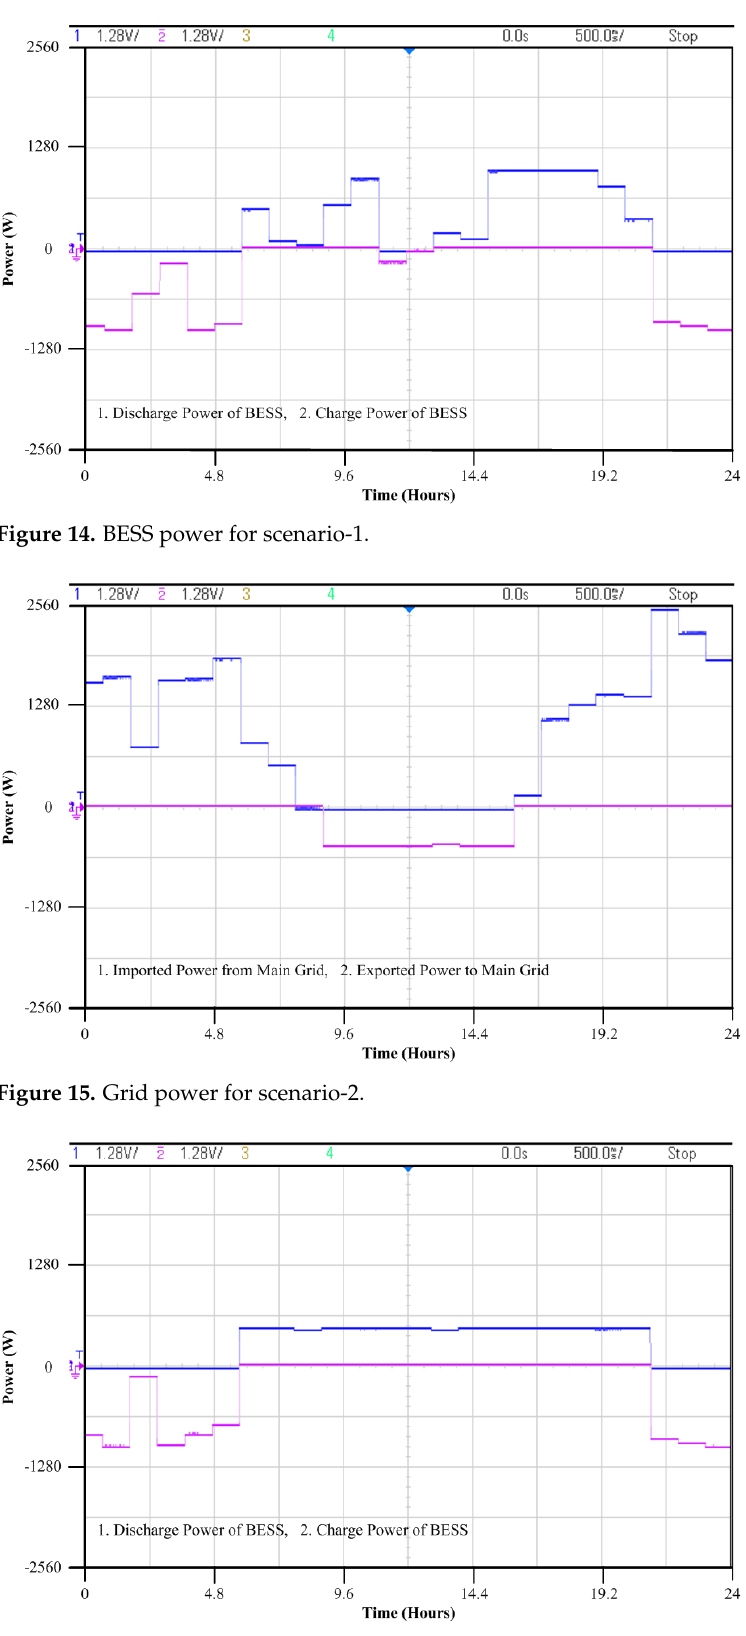
Figure 16. BESS power for